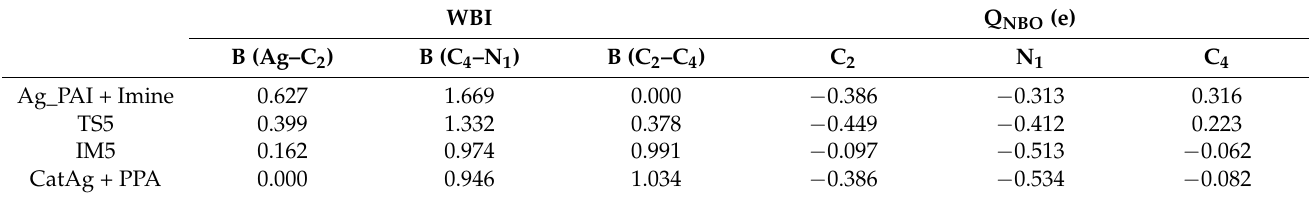
Table 4. WBI and Q NBO values for the imine ion and the silver phenylacetylide ( Ag_PAI ) reaction.